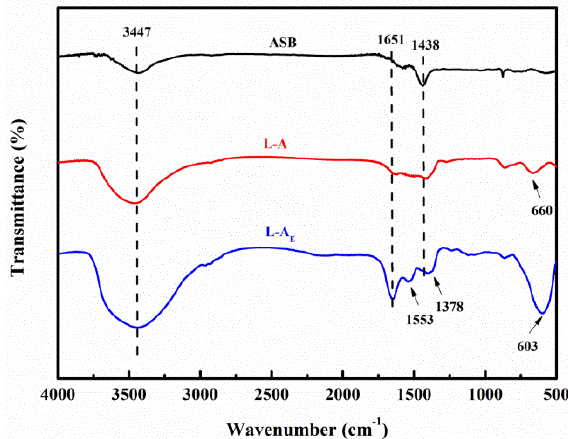
Figure 4. FTIR spectra of the materials.